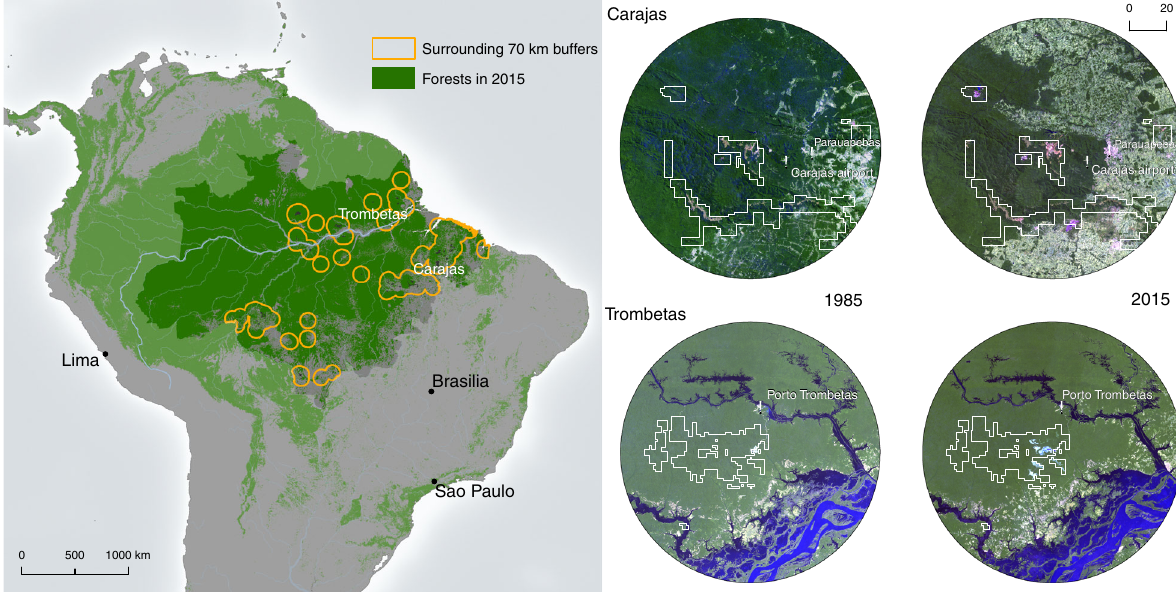
Fig. 1 Mining in Brazil ’ s Amazon forest. Left : distribution of mining leases and forests in 2015 4 . Right : case study mining operations. Mining leases are shown as white polygons overlying Landsat TM imagery for 1985 and 2015. Landsat pixel-based cloud-free mosaic, bands 3, 2, 1. Green areas indicate forests, bright white areas indicate non-forested ground, and blue areas are